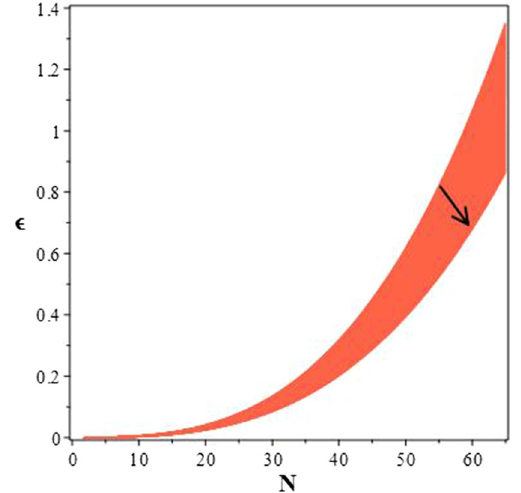
Fig. 3 The evolution of the potential in the intermediate MDBI model versus the scalar filed φ , with b = 10 and 0 . 340 < β < 0 . 400. The arrow shows the direction in which the parameter β increases Eqs. (18), (37), (38) and (39). By performing the numerical analysis, we find the result shown in the right panel of Fig. 1.